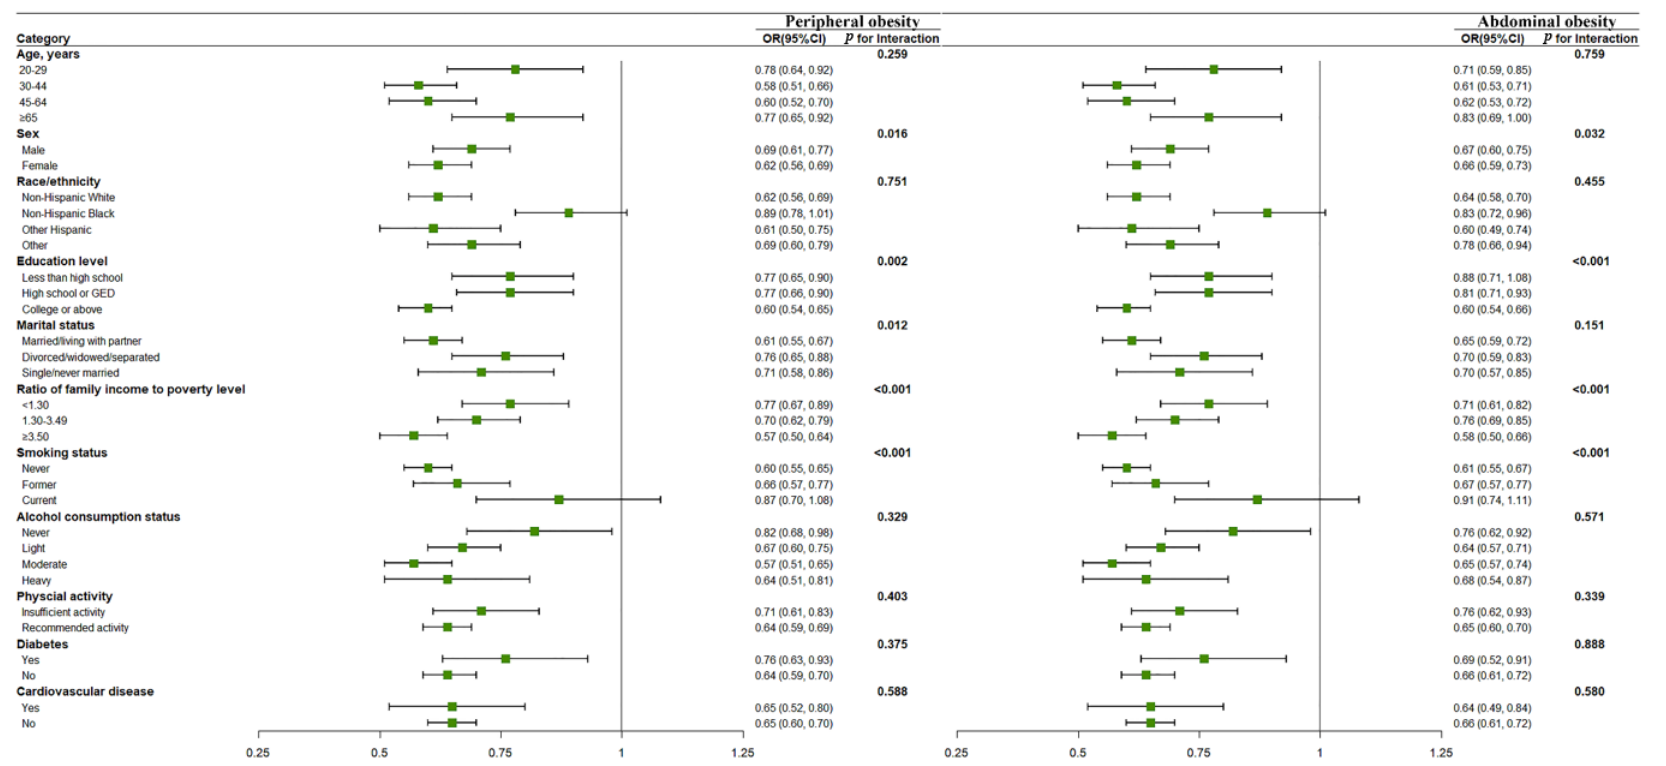
Figure 3. Subgroup analyses for the associations of HEI-2015 score (per interquartile range increment) with risk of obesity. Note: NHANES, National Health and Nutrition Examination Survey; BMI, body mass index; WC, waist circumference; HEI, The Healthy Eating Index. All results were adjusted for age, sex, race, education level, marital status, income, smoking, alcohol consumption, physical activity, diabetes, and cardiovascular disease, except for stratified variables sep- arately.